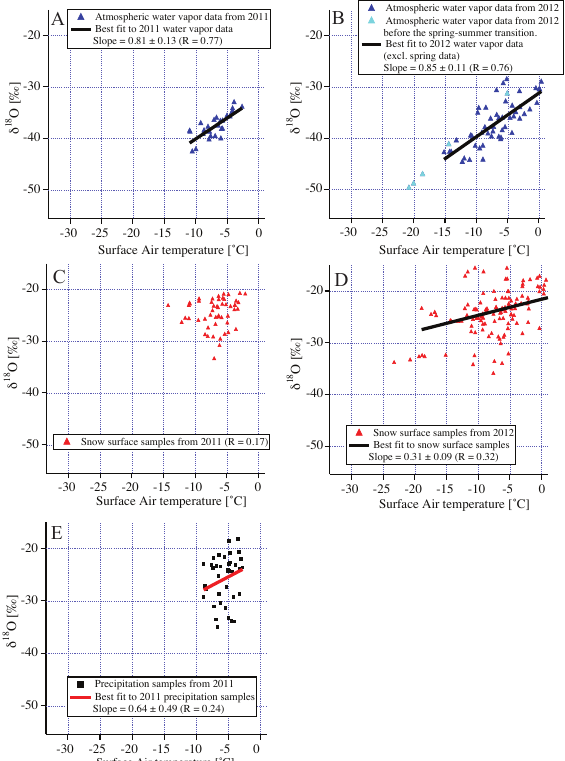
Fig. 3. The d-excess vs. δ 18 O for the observed mean daily water vapor isotopes ( A : 2011; B : 2012), surface snow samples ( C : 2011; D : 2012), and precipitation samples ( E : 2011). Table 3. Mean summer surface snow isotopic composition from ob- servations and the calculation of equilibrium with surface water va- por at surface air